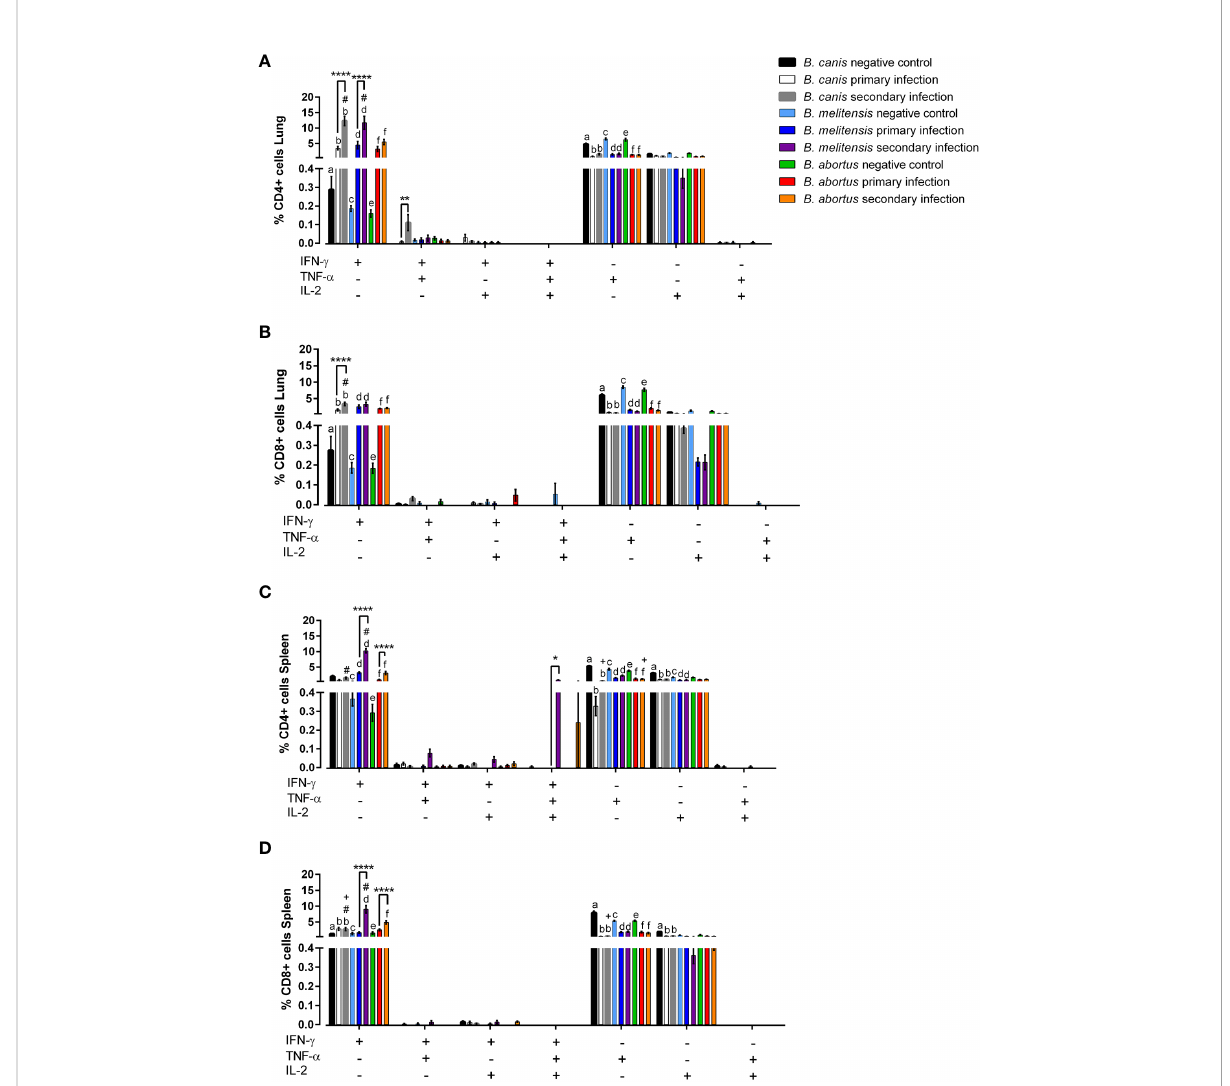
FIGURE 6 Rough and smooth Brucella spp. induce signi fi cant IFN- g -producing T-lymphocytes, more so during secondary exposure, but only smooth Brucella do so at the systemic level. Flow cytometric analysis of T-lymphocyte cytokine production was performed following primary or secondary inoculation of female C57BL/6J mice with 10 7 CFU B . melitensis, B. abortus , or B . canis . (A) CD4+ and (B) CD8+ T-lymphocytes were evaluated in the lungs and (C) CD4+ and (D) CD8+ T lymphocytes were also evaluated in the spleen. Data were analyzed using two-way ANOVA with Sidak ’ s multiple comparisons test. Signi fi cant differences between groups are indicated (**p < 0.01, ***p< 0.001, ****p < 0.0001), between groups and the B . abortus secondary infection group (#p < 0.05), and between groups and the B . melitensis secondary infection group (+p < 0.05). There are signi fi cant differences (p < 0.05) in the graph between “ a ” and “ b, ” “ c ” and “ d, ” and “ e ” and “